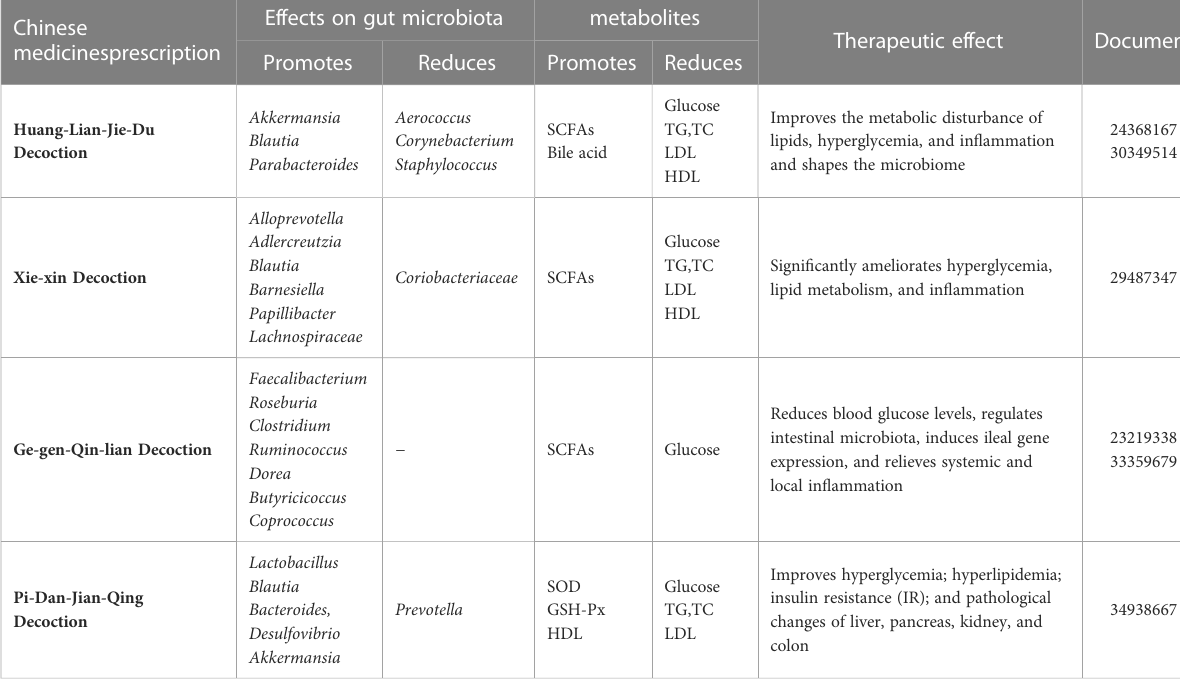
TABLE 2 Progress on the prescription of Chinese herbal compounding acting on intestinal microbiota in the treatment of